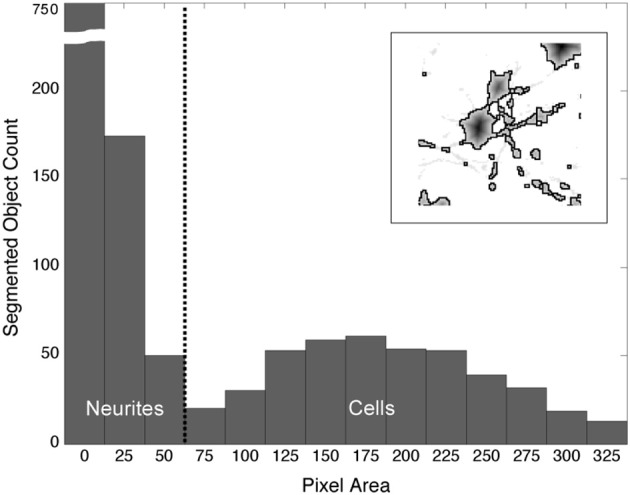
Distribution of segmented objects binned according to pixel area. The morphological differences between neurites and somata produce watershed segmentation boundaries that, when binned according to pixel area, fall into two distinct populations. The threshold, α (vertical, dashed line), is used to separate objects into neurites and cell bodies. Objects with a pixel count or area ≥ α are labeled “cells”; objects with an area < α are labeled “neurite fragments.” (Inset) Watershed boundaries for somata and neurite fragments.